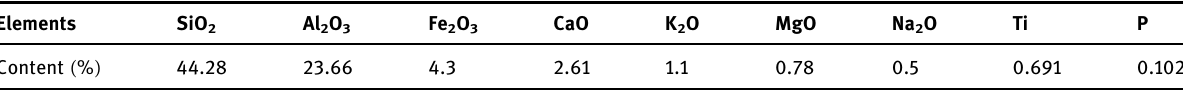
Table 1: Elemental analysis of CFA*